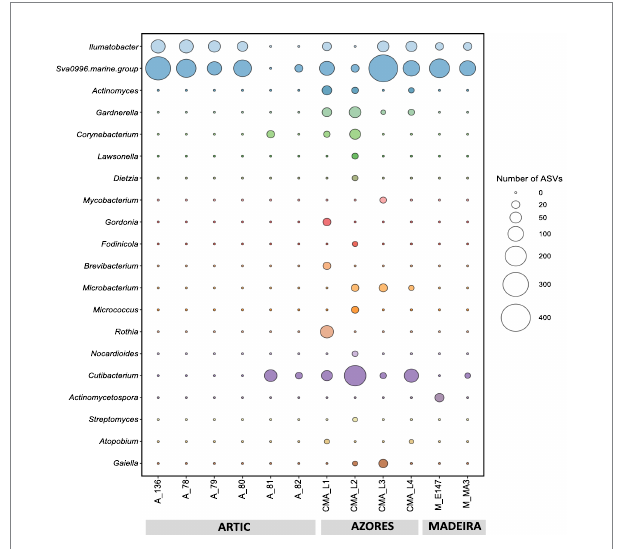
FIGURE 3 Absolute abundances (as number of ASVs) of the actinobacterial genera found across the deep-sea